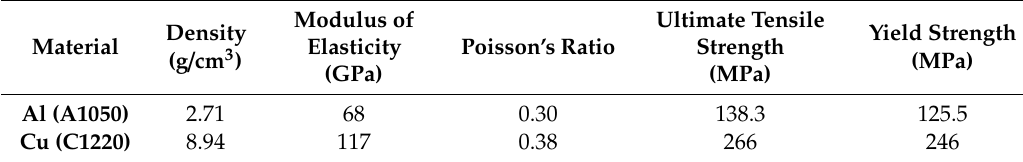
Figure 2. Ultrasonic metal welding systems employed in experiment. ( a ) Systems configuration; ( b ) pattern shape on horn. Table 1. Mechanical properties of base metal.